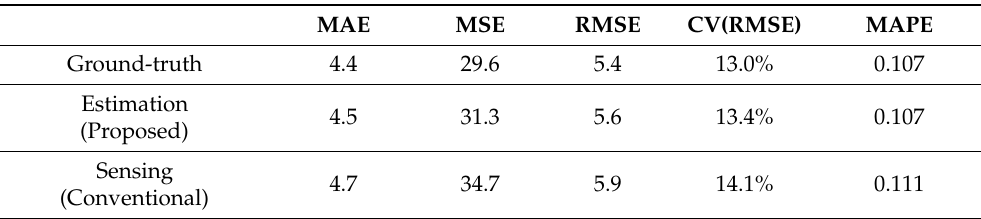
Table 3. Evaluation of energy consumption prediction.